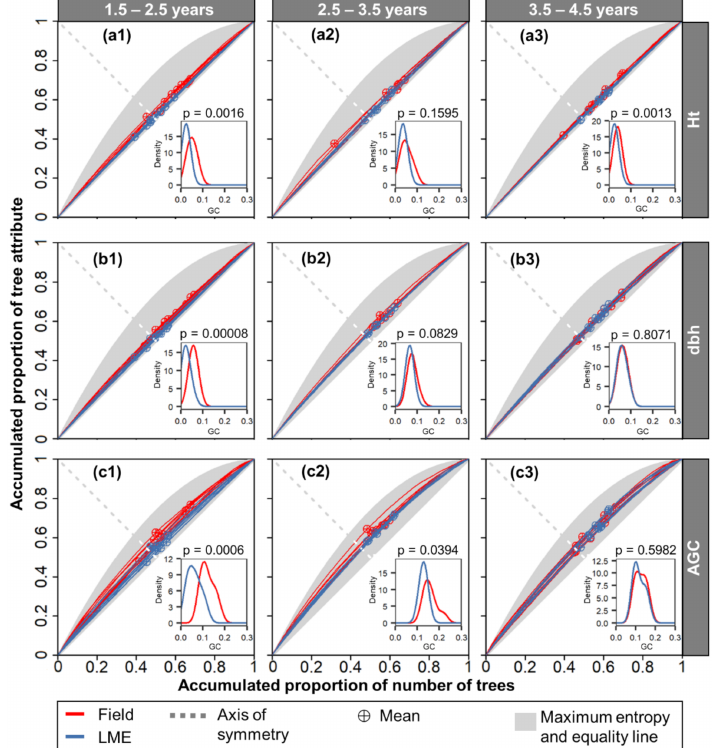
Figure 8. Lorenz curves and Gini coe ffi cient (GC) of the tree attributes as calculated from the field-measured observations (red) and estimated values (blue) using the linear mixed-e ff ects model (LME) with the stand (SID) as a random-e ff ect variable. The tree attributes were aboveground carbon (AGC), diameter at 1.3 m above the ground (dbh), and height (Ht) ( a – c , respectively) at ages of 1.5–2.5, 2.5–3.5, and 3.5–4.5 (subscript 1 , 2 , and 3 , respectively). Curves and coe ffi cients were calculated for each sample plot. The p -value ( p ) for the Student’s t-test of mean di ff erences between the field and LME derived GC